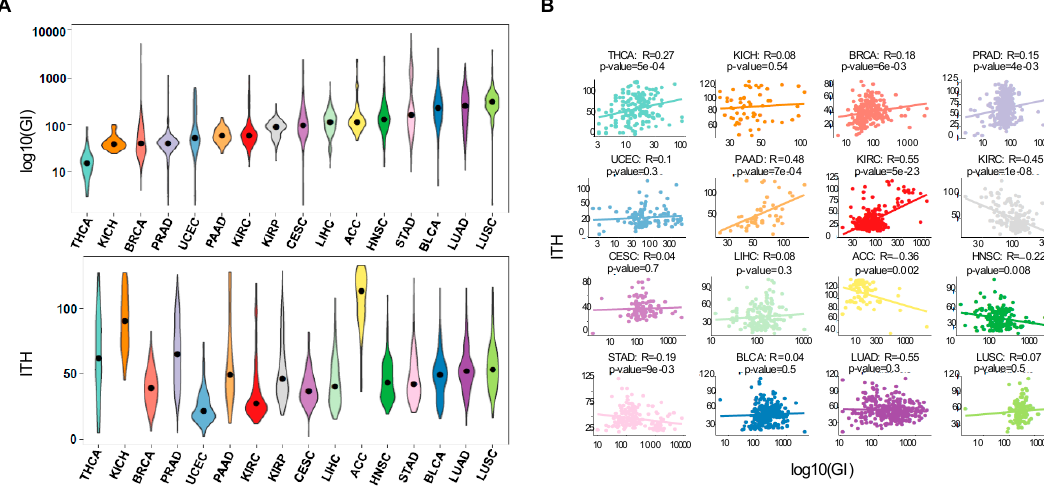
Figure 1. Pan-cancer correlations reveal that genomic instability does not predict ITH. ( A ) Distribution of genomic instability (log10 transformed) and ITH across 16 TCGA cancer types: THCA (thyroid carcinoma), KICH (kidney Chromophobe), BRCA (breast invasive carcinoma), PRAD (prostate adenocarcinoma), UCEC (uterine Corpus Endometrial Carcinoma), PAAD (pancreatic adenocarcinoma), KIRC (kidney renal clear cell carcinoma), KIRP (kidney renal papillary cell carcinoma), CESC (cervical squamous cell carcinoma and endocervical adenocarcinoma), LIHC (liver hepatocellular carcinoma), ACC (adrenocortical carcinoma), HNSC (head and neck squamous cell carcinoma), STAD (stomach adenocarcinoma), BLCA (bladder urothelial carcinoma), LUAD (lung adenocarcinoma), LUSC (lung squamous cell carcinoma). Cancers are ordered according to genomic instability levels. ( B ) Pearson correlation between genomic instability (log10 transformed) and ITH for each cancer type. Each point represents one patient and the line shows the fitted linear model.